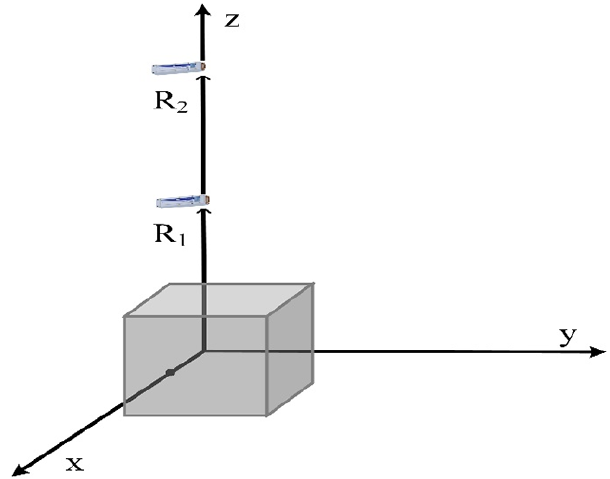
Figure 2. Observation points (magnetometers) in close proximity to the